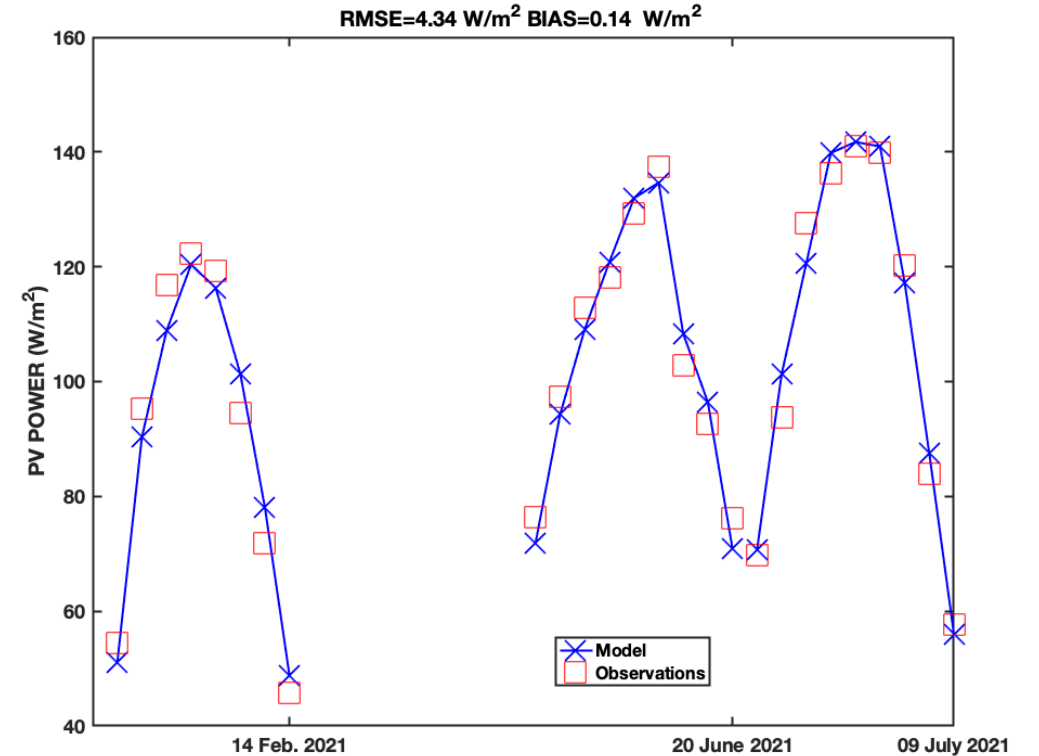
Figure 3. Intercomparison between the measured photovoltaic power and the power forecast by the simplified model developed in Section 2. The results show a RMSE of 4.34 W/m 2 and a bias of 0.14 W/m 2